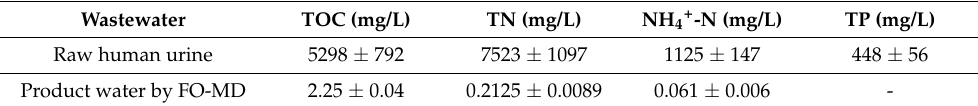
Table 4. The physicochemical properties of raw human urine and product water by the FO-MD process